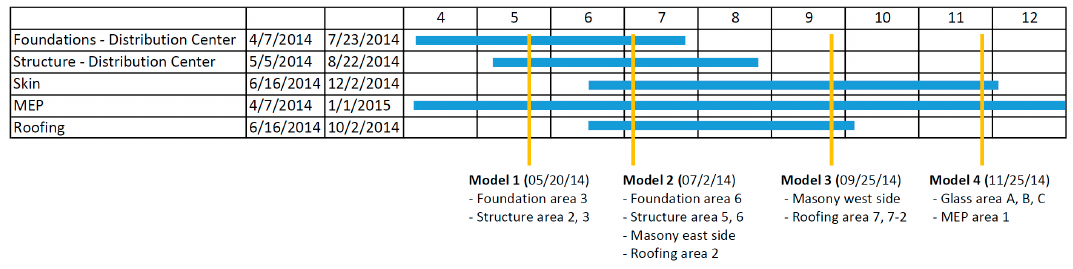
Figure 6. Scenario Model 1: Work status and site conditions.